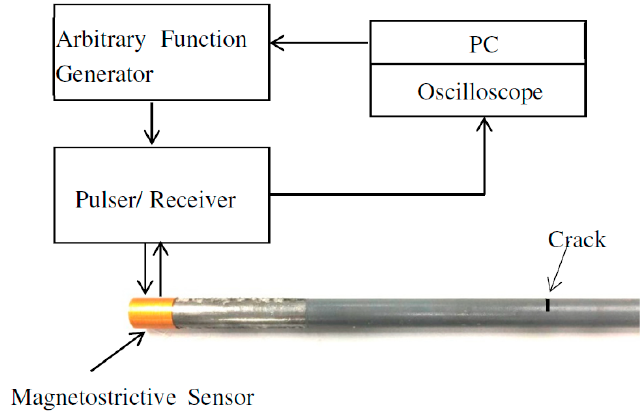
Figure 13. The schematic diagram of the experimental setup.